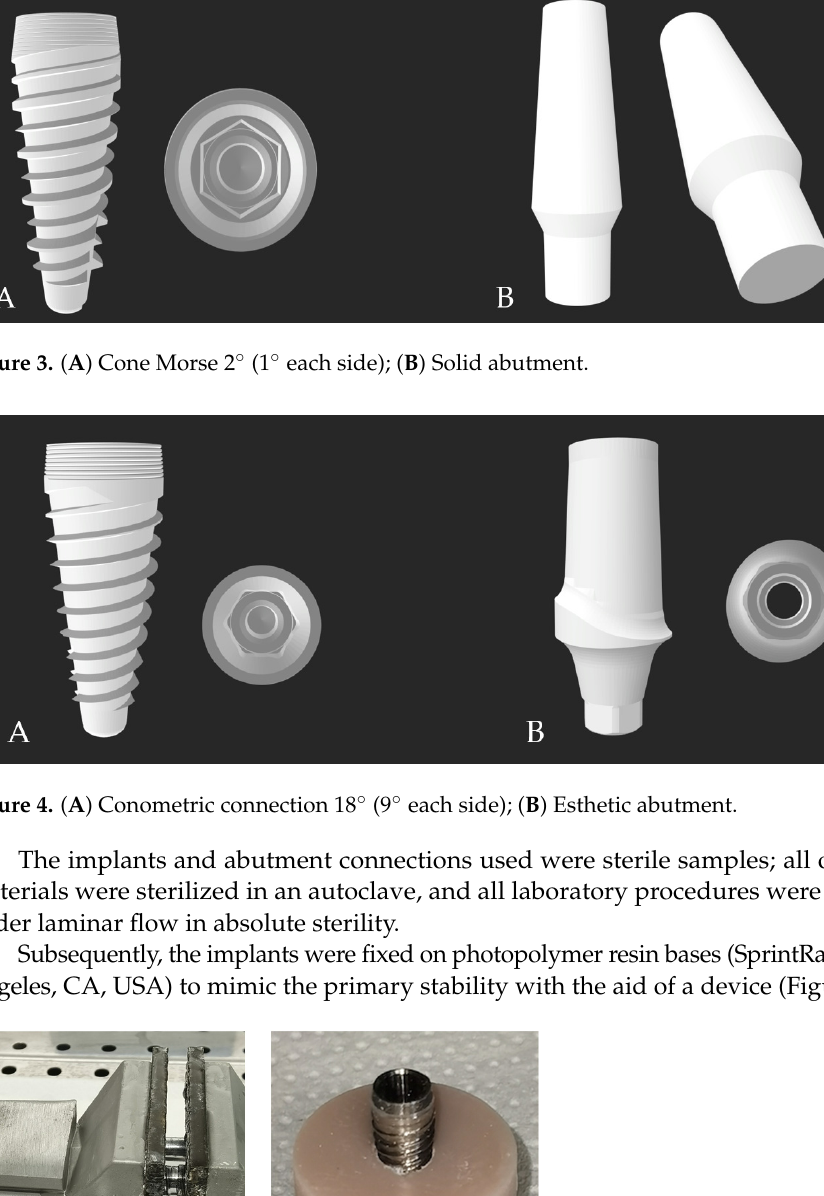
Figure 2. ( A ) Cone Morse 2° (1 ° each side); ( B ) Abutment with passing screw.